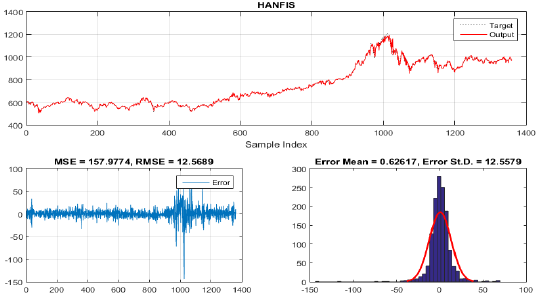
Fig. 16. VN Index forecasting performance by HANFIS model: (a) forecasting and actual values, (b) error value and (c) standard deviation